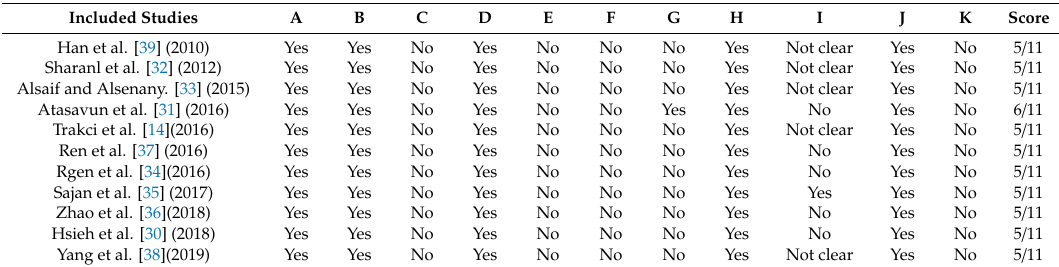
Table 2. Methodological quality assessment for the included studies.